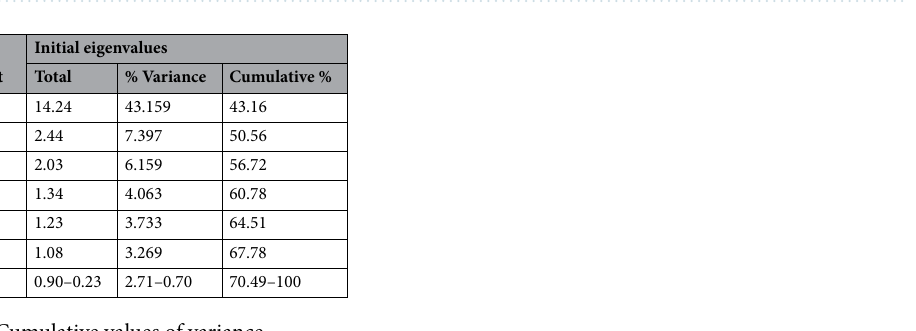
Table 1. Cumulative values of